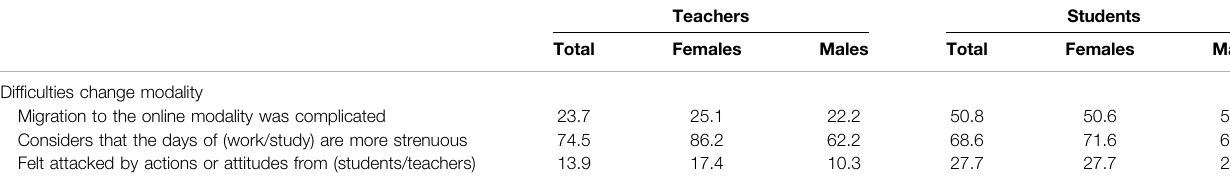
TABLE 4 | Dif fi culties faced by teachers and students due to the change of teaching